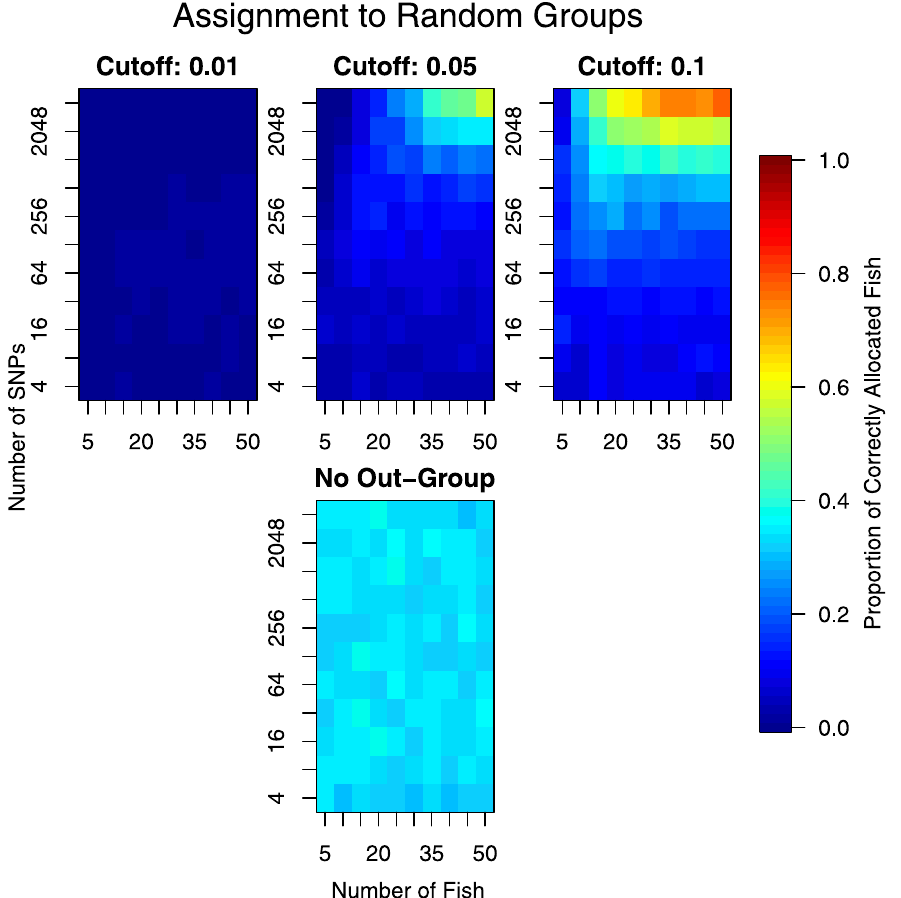
Fig 9. Results from individual assignment analysis to randomised sampling locations. Only locations from the Western Pacific (excluding Baja California) are used in this analysis. All other values as per Fig 7. If assignment is random, as it should be, then all values should be 1/K =